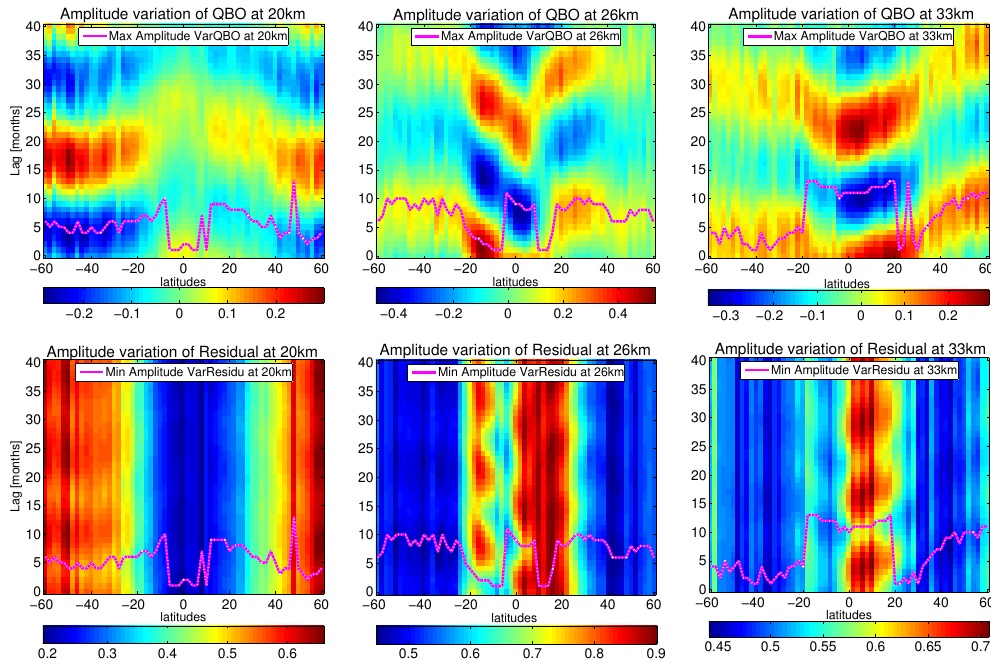
Fig. 11. Time-latitude cross-sections of the amplitude variation of the QBO component (upper) and residual (lower) at altitudes 20km, 26km and 33km as a function of the lag τ qbo with respect to CDAS QBO index. The magenta curves show the lag which maximizes the QBO component in the upper panels and which mimimizes the residual in the lower panels as a function of latitude. Amplitudes are in yr and each panel has its own